Question: Summarize what this figure shows in one sentence.
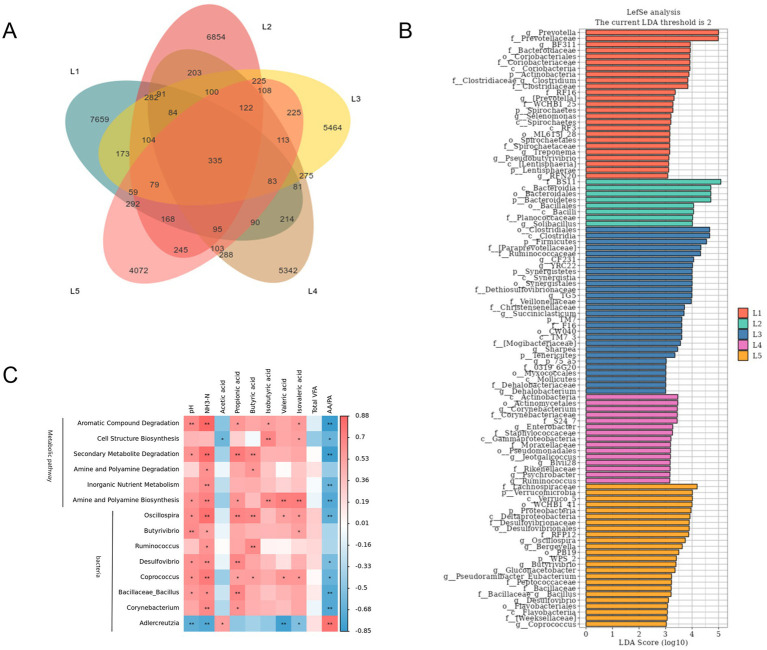
Answer: Rumen bacterial community structure, differentially abundant genera, and their correlations with fermentation parameters. (A) Venn diagram showing the number of shared and unique OTUs across the five treatment groups. (B) LEfSe analysis (LDA > 2.0, FDR-adjusted p < 0.05) identifying differentially abundant genera among the five groups. (C) Spearman correlation analysis between rumen microbiota/metabolic pathways and rumen fermentation parameters (* p < 0.05, ** p < 0.01). L represents rumen fluid; groups 1, 2, 3, 4, and 5 represent sweet sorghum to aerial parts of licorice ratios of 100:0 (100%SS), 75:25 (75%SS), 50:50 (50%SS), 25:75 (25%SS), and 0:100 (0%SS), respectively.